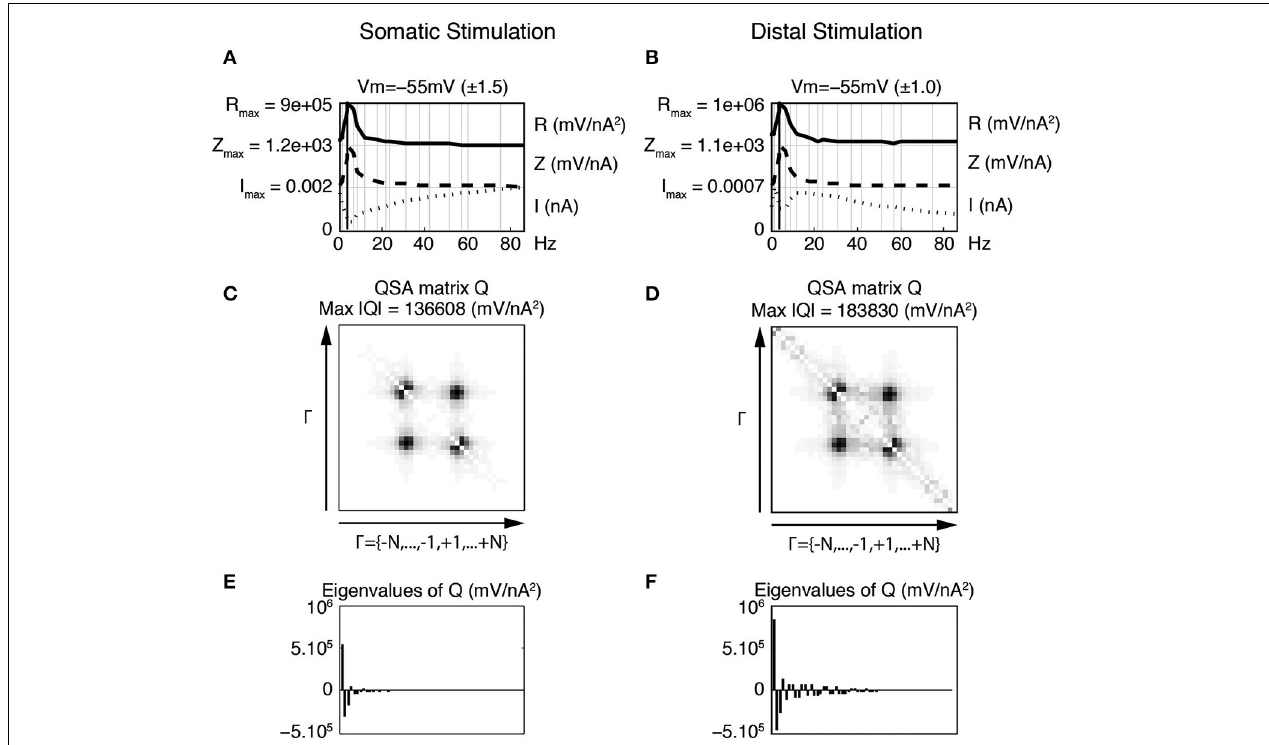
FIGURE 10 | Effect of distal vs. proximal flat stimulation on somatic nonlinearities. The linear and quadratic functions were calculated using only the current passing across the soma membrane, as opposed to the total injected current. Thus, the analyses apply to the soma independent of the location of the stimulating electrode. Left column (A,C,E) Responses to the flat stimulation of the somatic compartment. Right column (B,D,F) Responses to the flat stimulation applied at the